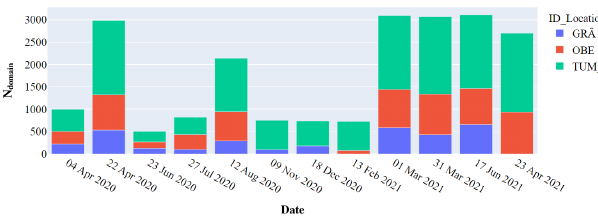
Figure 6. Number of good-quality OCO-2 soundings N domain in the three comparison